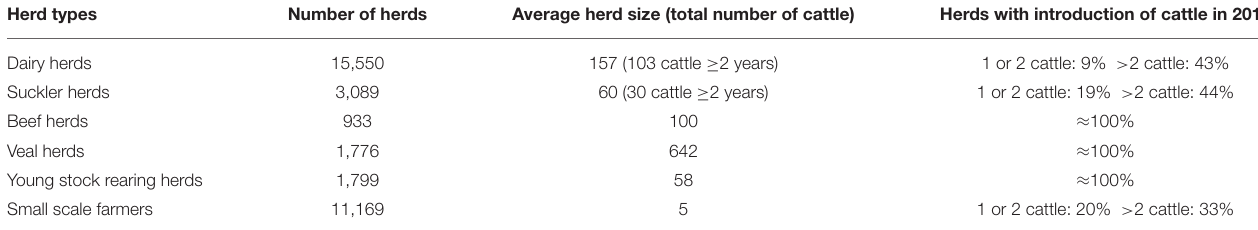
TABLE 1 | Number of cattle herds and average herd size per cattle herd type in the Netherlands in 2019. Herd types